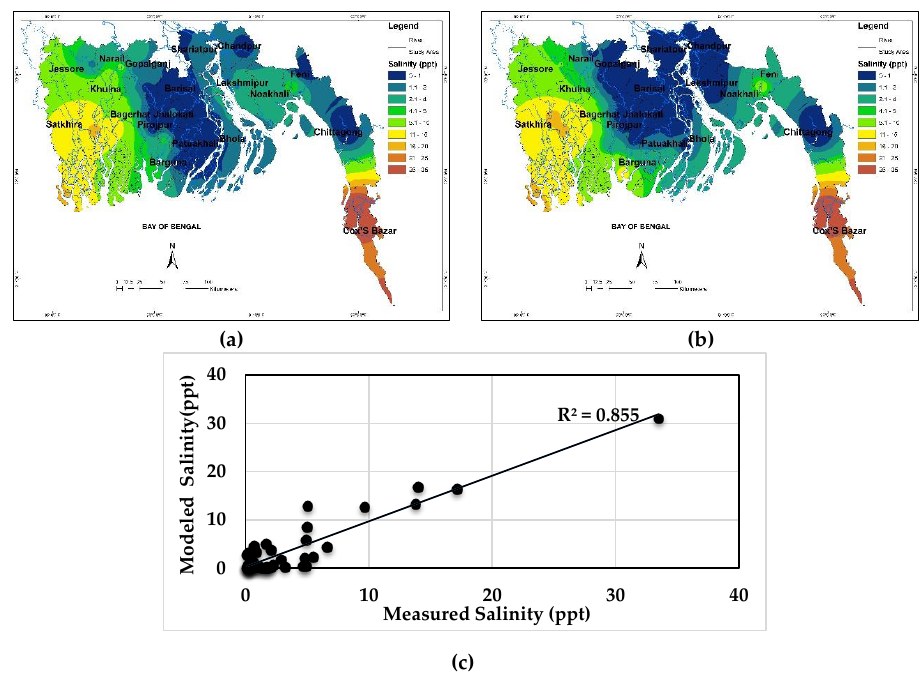
Figure 3. Validation result of salinity model that shows comparison of maximum salinity values in the study area during the year 2010. The result shows ( a ) measured and ( b ) modeled simulated salinity values in ppt. ( c ) Measured salinity vs. modeled